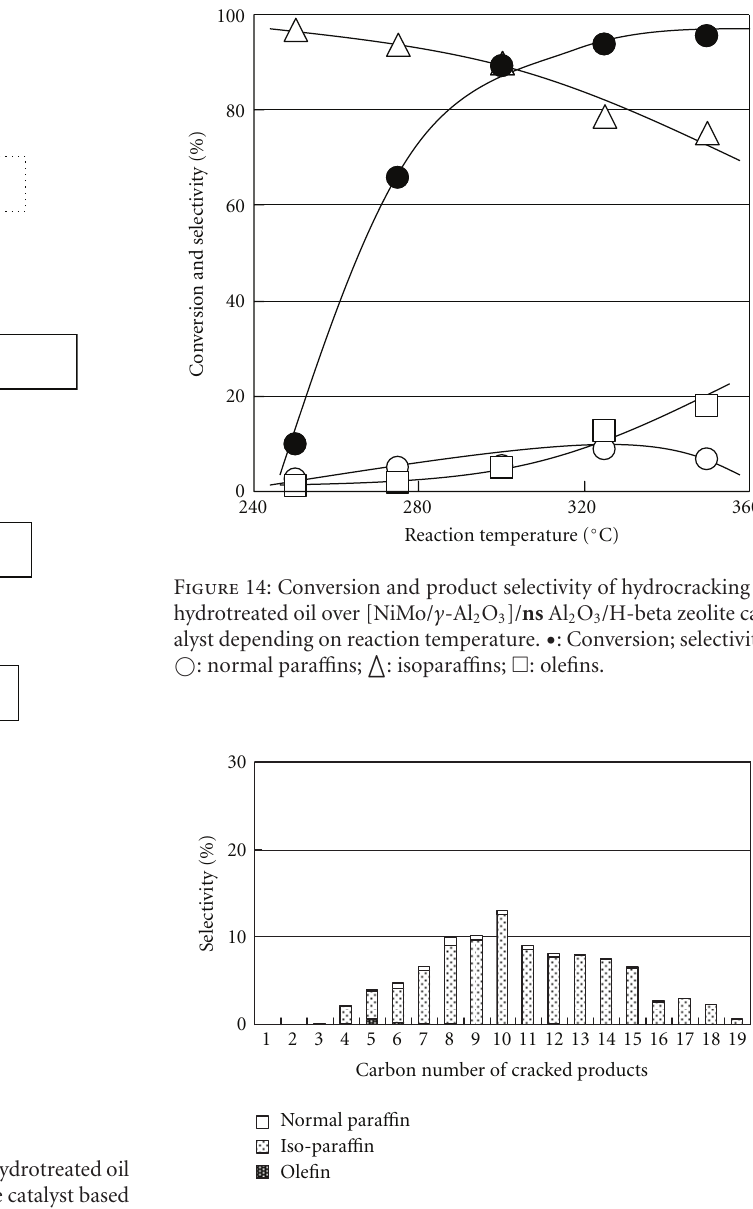
Figure 15: Product distribution of hydrocracking of hydrotreated oil over [NiMo/ γ -Al 2 O 3 ]/ ns Al 2 O 3 /H-beta Zzeolite catalyst at 275 ◦ C.